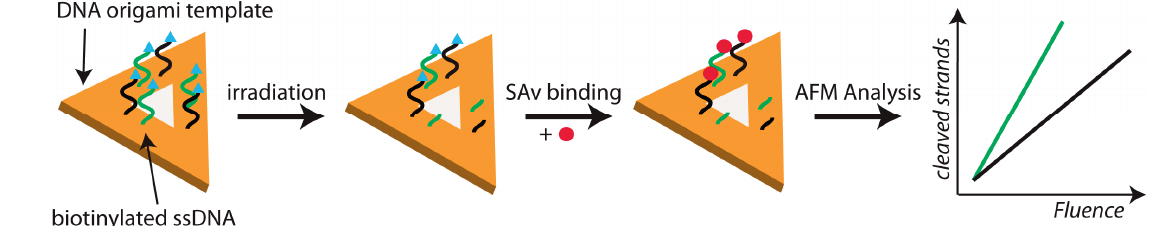
Figure 5. Scheme of the experimental sequence used to quantify electron-induced strand breakages [26]. Triangular DNA origami nanostructures with six protruding strands with two different target structures (indicated in green and black) are irradiated with low-energy electrons.